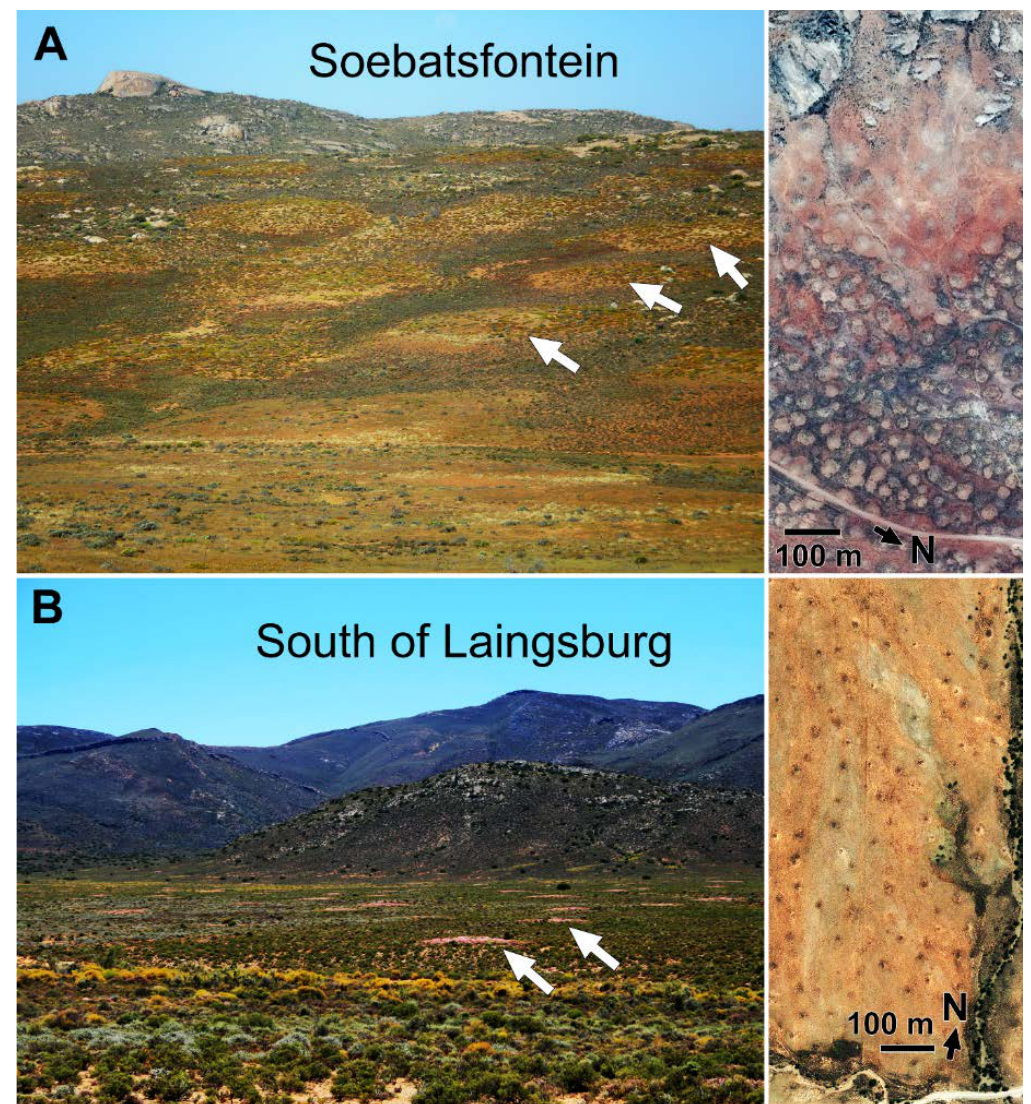
Figure 5. ( A ) Ground photo (left side) paired with a Google Earth™ view of the Soebatsfontein site (right side). Heuweltjies are the large, lighter-colored patches (several indicted with white arrows). Heuweltjies at this site are approximately 30 m wide, from 1–2 m in height, and collectively cover approximately a quarter of the land surface. ( B ) Ground photo (left side) paired with a Google Earth™ aerial view of the South of Laingsburg site (right side). The light-colored (pinkish) vegetation of heuweltjies at this site (white arrows) consists of flowering Mesembryanthemum junceum, the dominant perennial plant on mounds, but not in intervening areas. Heuweltjies at this inland site range from 8–15 m diameter with maximum heights of approximately 0.5 m and cover only an estimated 3% of the land surface, despite similar densities of heuweltjies (4.5/ha and 3.8/ha) at Soebatsfontein and South of Laingsburg , respectively.